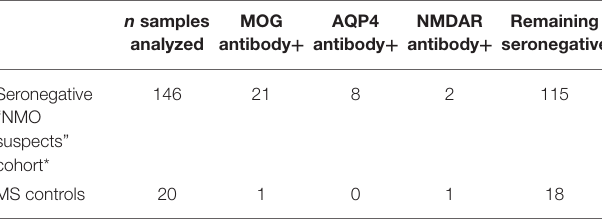
TABLE 1 | Results of antibody testing in retrospective cohort.